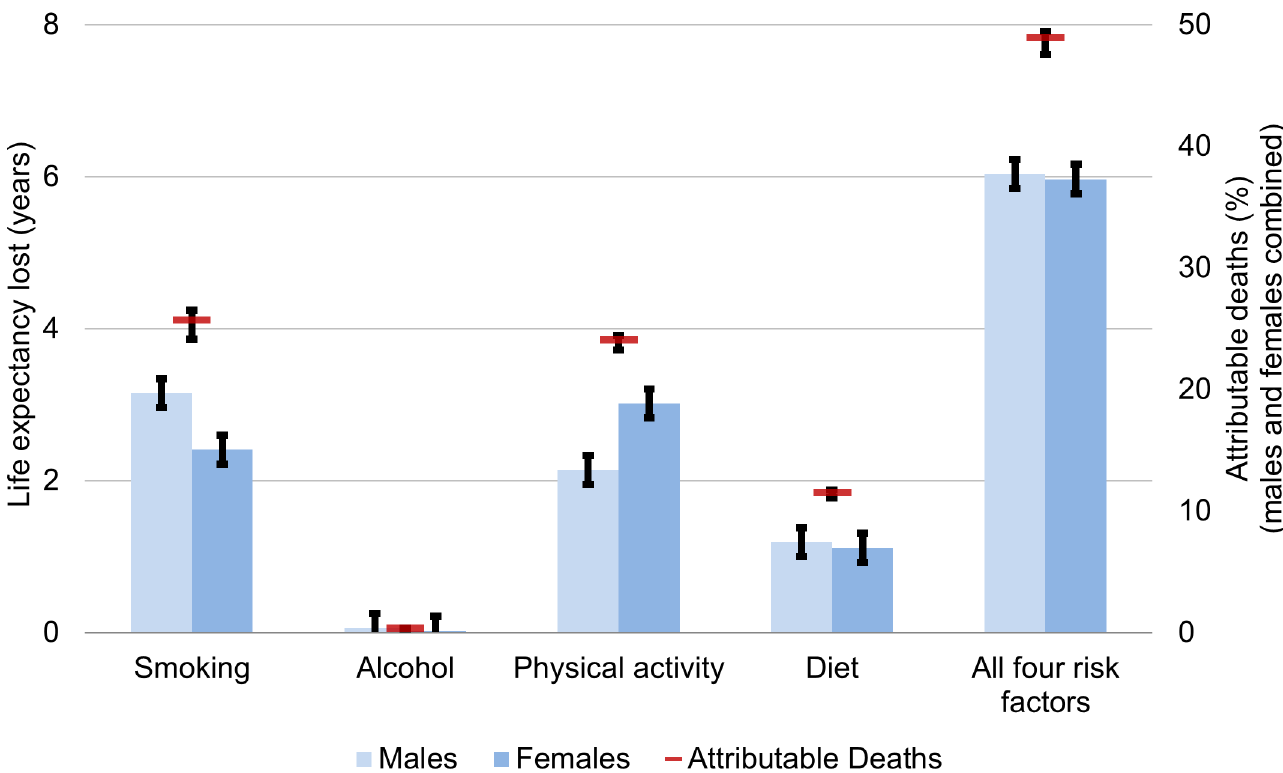
Fig 2. Unhealthy behaviour attribution to life expectancy lost and mortality for Canadians aged 20 and older, 2010. Life expectancy gain and attributable deaths from full MPoRT model (incorporating age, health behaviours, sociodemographic and disease indicators) applied to Canadian national cohort. Error bars represent 95% confidence